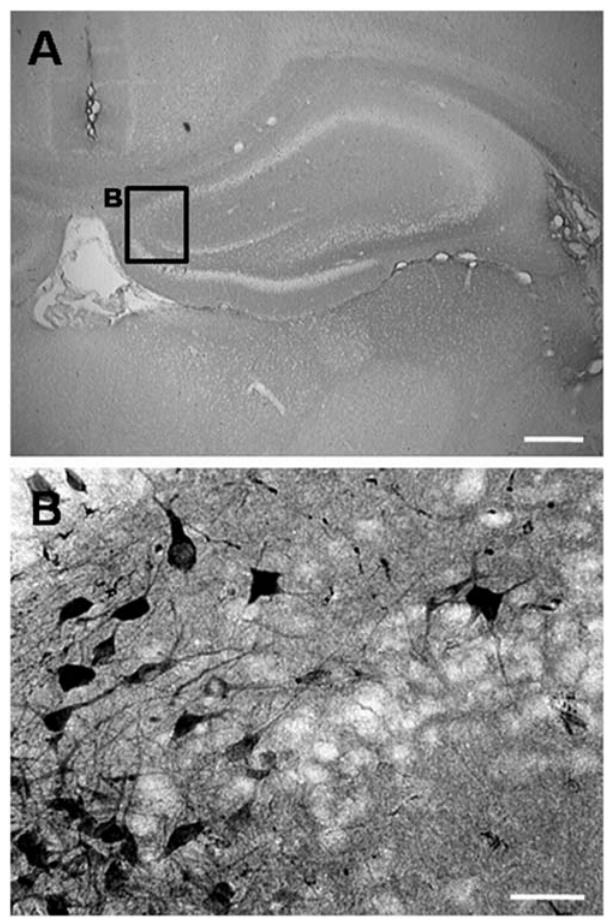
Figure 6. Survival of grafted F3.Akt1 human NSCs in hippo- campus was demonstrated by immunoperoxidase microscopy of hNuMA at 8 weeks post-transplantation (PT). A: Lower magnification of hippocampus 8 weeks PT. Bar indicates 1 mm. B: F3.Akt1 human NSCs grafted in cortex overlying striatum were found to migrate extensively to hippocampus 8 weeks PT. Bar indicates 50 m